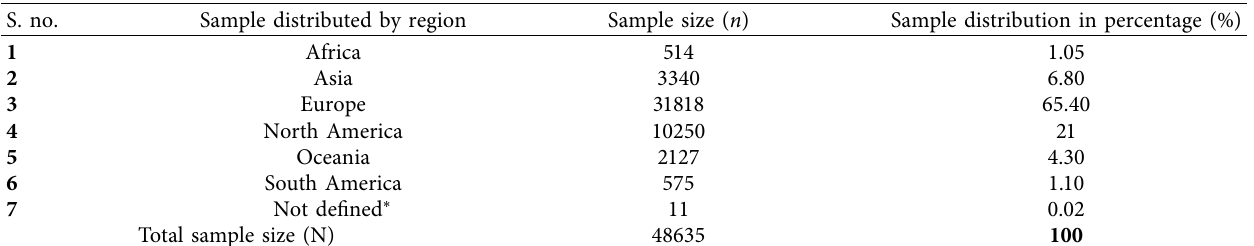
Table 1: Sample size and distribution of SARS-CoV-2 genomes on the basis of region for this study. S.